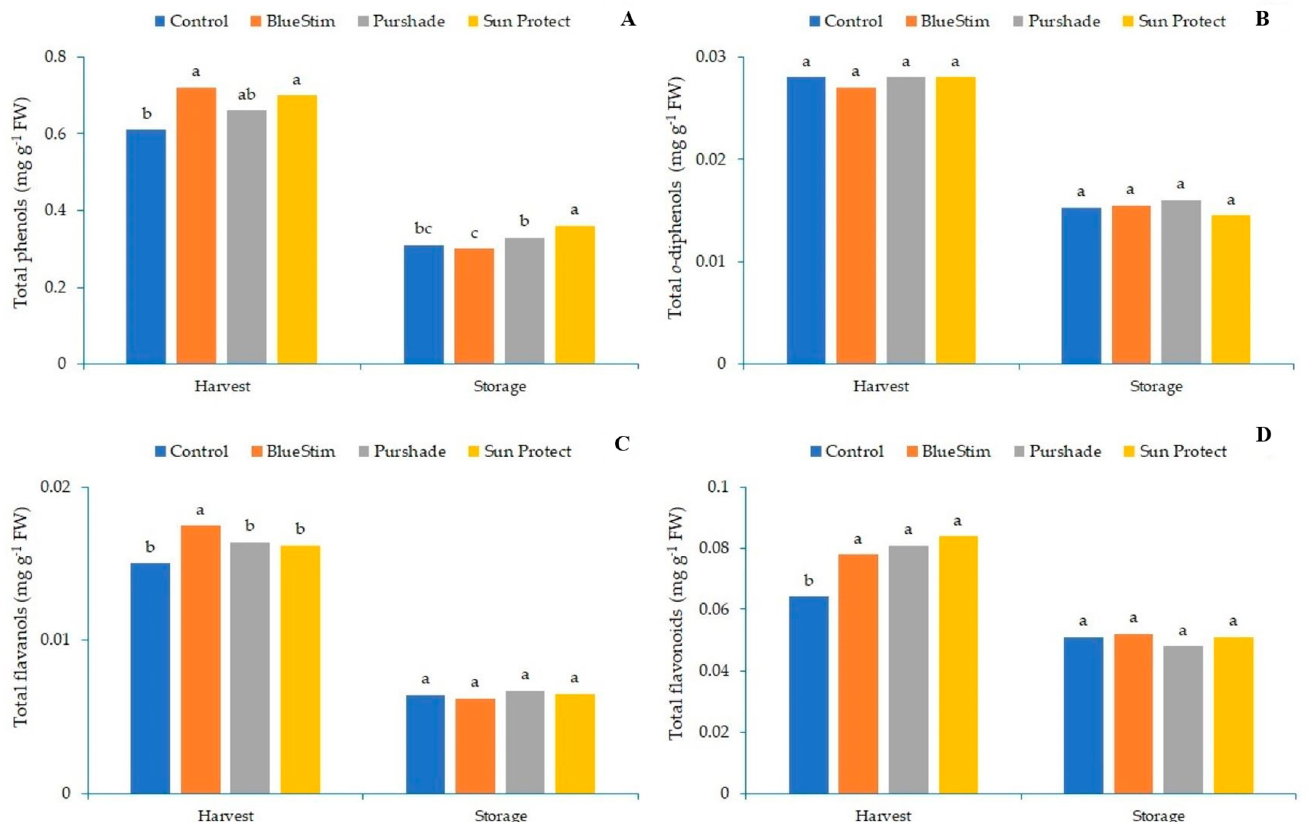
Figure 3. Effect of alleviating products on kiwifruit phenolic compounds concentration (( A ), total phenols, ( B ), total o-diphenols, ( C ), total flavanols and ( D ), total flavonoids) at harvest and after storage at 0.5 ◦ C for 107 days. Treatment columns with the same letter above, within the same production event (harvest or storage), do not significantly differ according to Tukey’s HSD multiple range test at α = 0.05. Table 5. Alleviating products’ effect on kiwifruit antioxidant capacity ( µ mol equiv. Trolox g − 1 fresh weight) at harvest and after storage at 0.5 ◦ C for 107